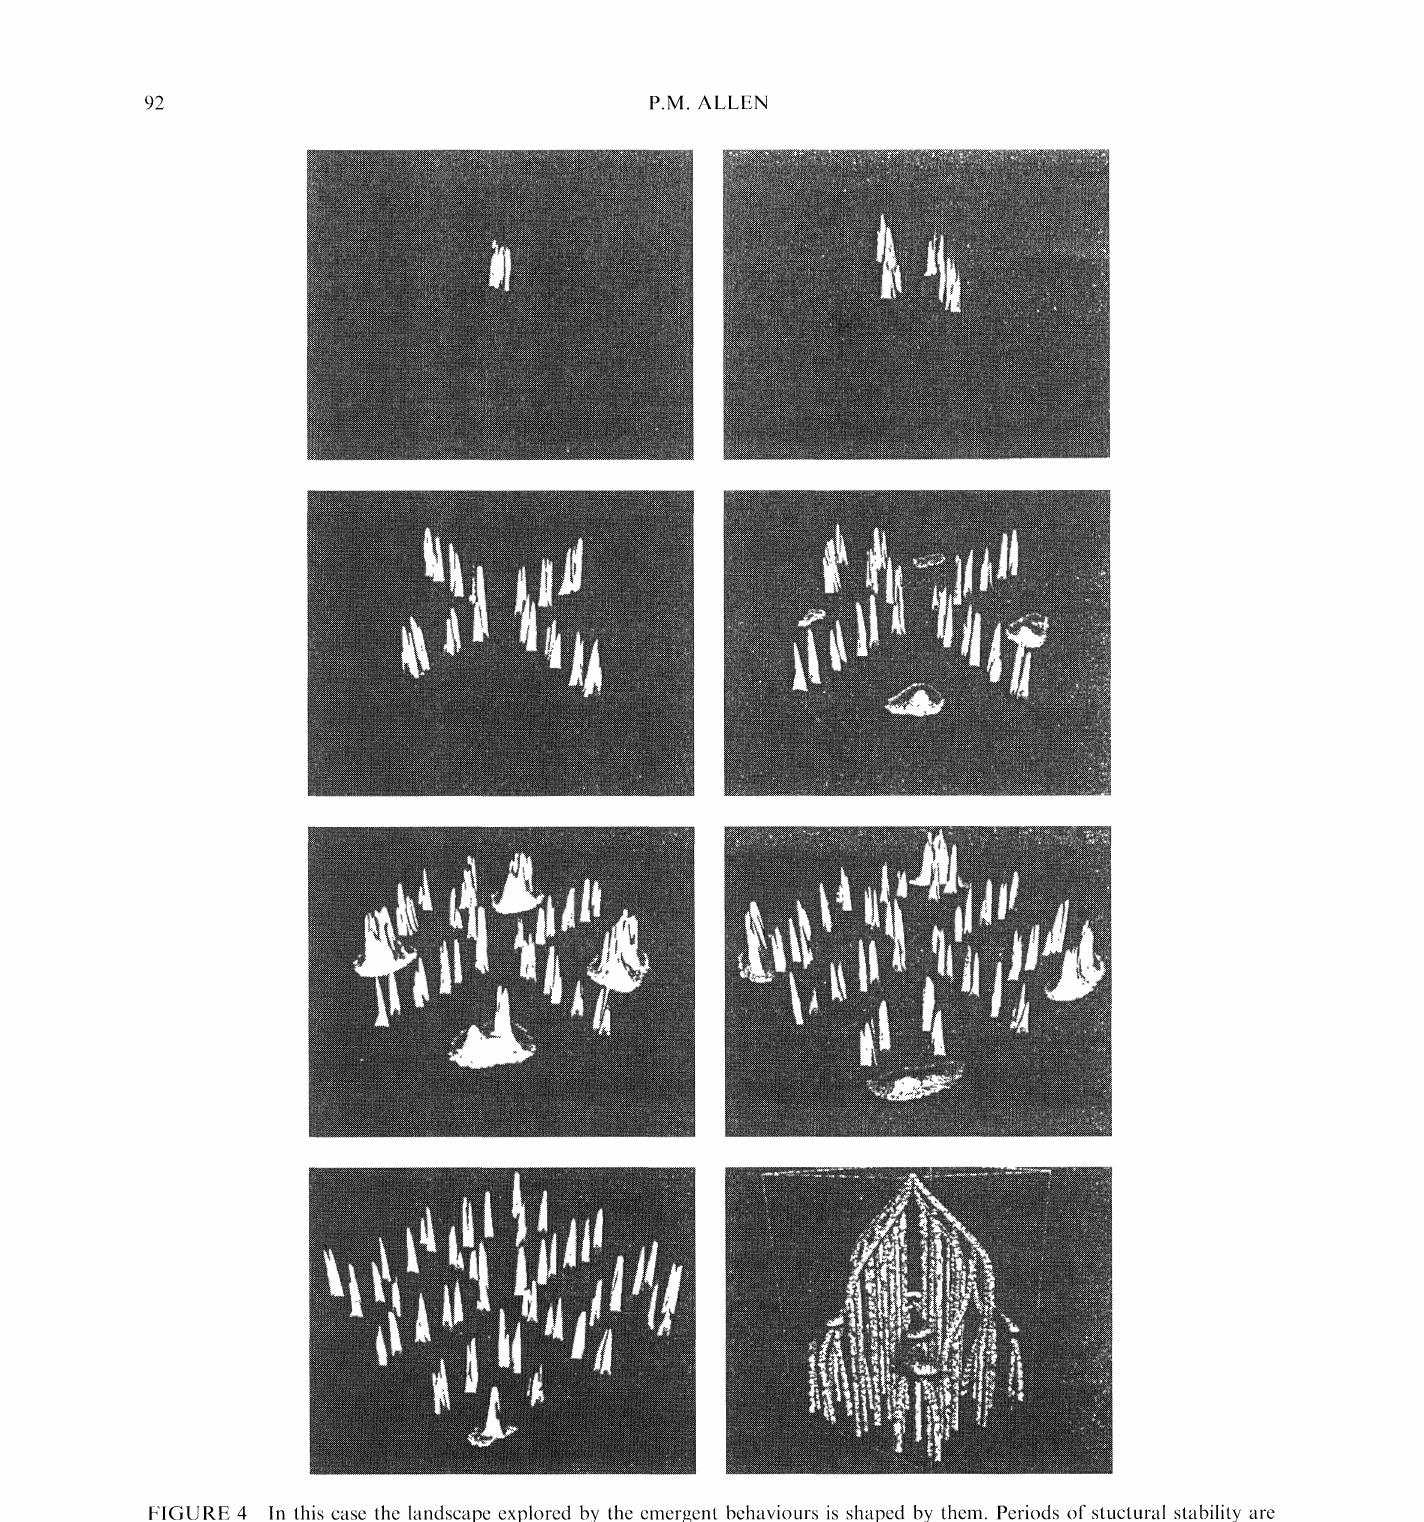
FIGURE 4 In this case the landscape explored by the emergent behaviours is shaped by them. Periods of stuctural stability are separated by periods of change, depending on whether the system can control its own error-making or